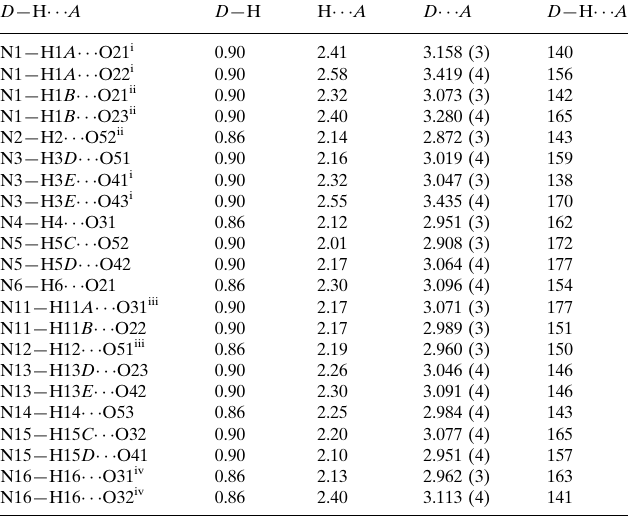
Hydrogen-bond geometry (A˚ , (cid:2)